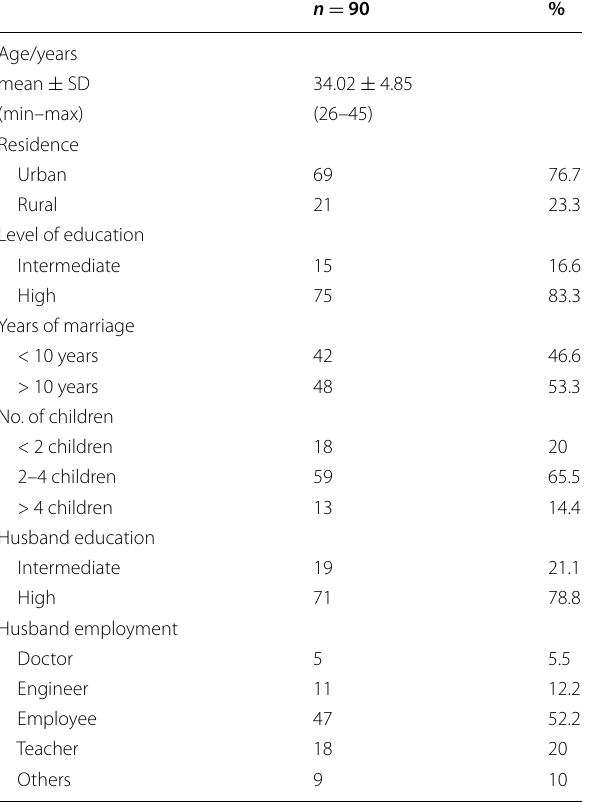
Table 1 Socio-demographic data of the studied females